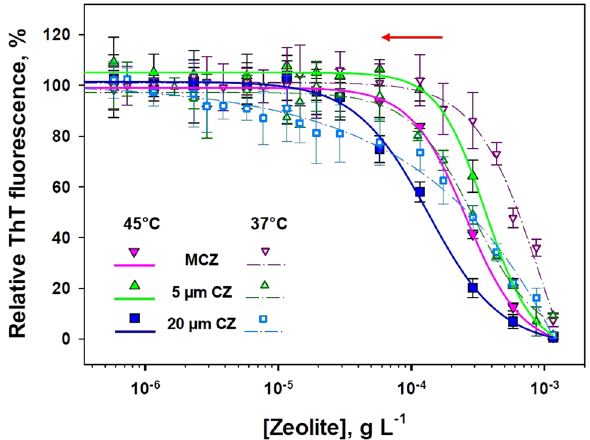
Figure 7. Determination of disassembly effect of CZ particles at normal and “hyperthermic” conditions monitored via ThT assay. Effect of selected CZ particles on amyloid fibrils was monitored at normal conditions (37 °C; open symbols and dash lines) and at “hyperthermic” conditions (45 °C; filled symbols and solid lines). The extent of destroying of amyloid fibrils was monitored using ThT fluorescence assay. The error bars represent the average deviation for repeated measurements of three separate